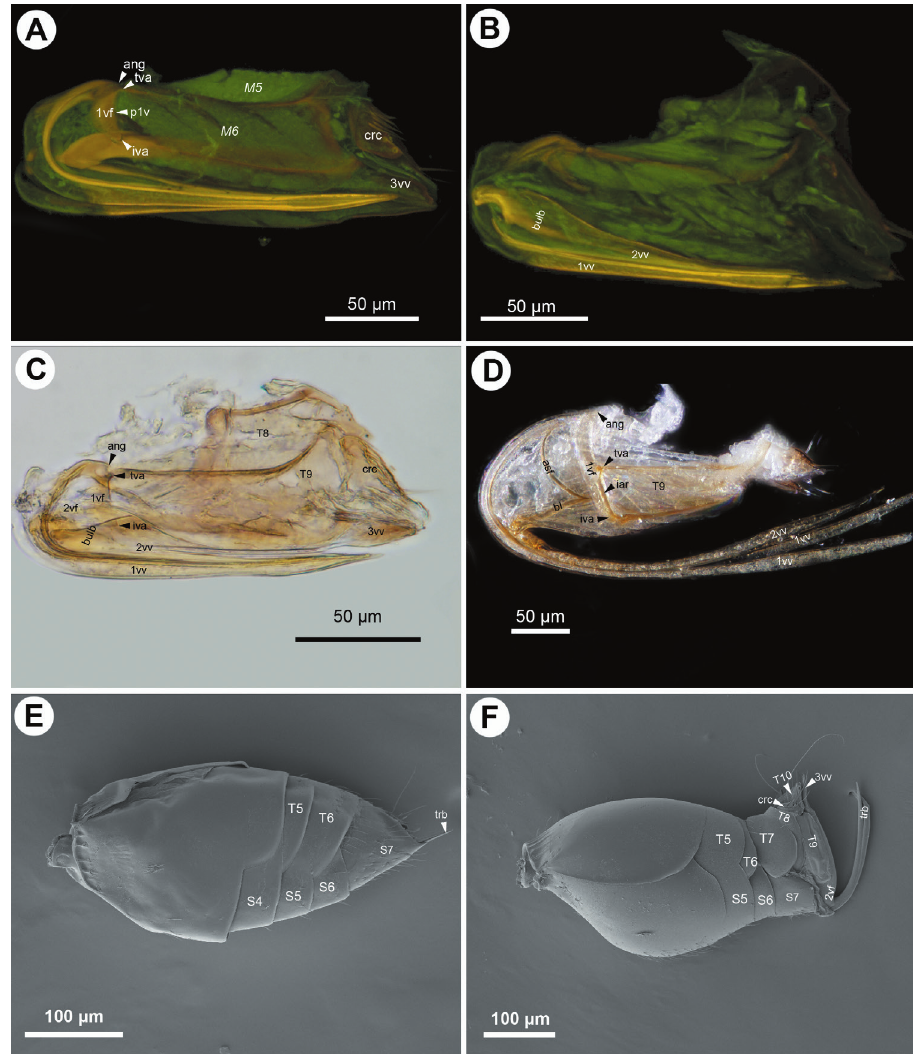
Figure 6. CLSM micrographs and bright field image showing the female terminalia of Ceraphronidae. A–C : Aphanogmus sp. 1: A CLSM, lateral view (doi: 10.6084/m9.figshare.156439) B CLSM, medial view (doi: 10.6084/m9.figshare.156446) C bright field, lateral view D Aphanogmus sp. 2, bright field, lateral view e Synarsis sp., SEM, lateral view F Cyoceraphron sp., SEM, lateral view. All anterior to